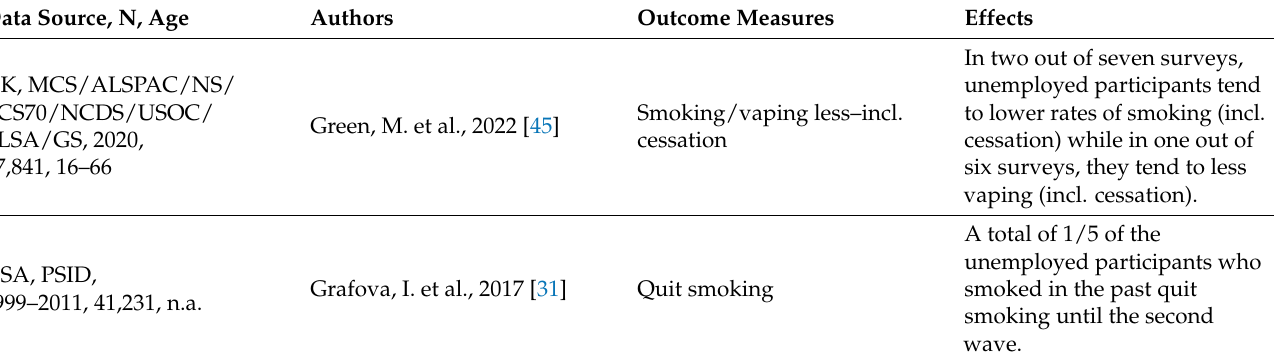
Table 5. Unemployment reducing the success of smoking